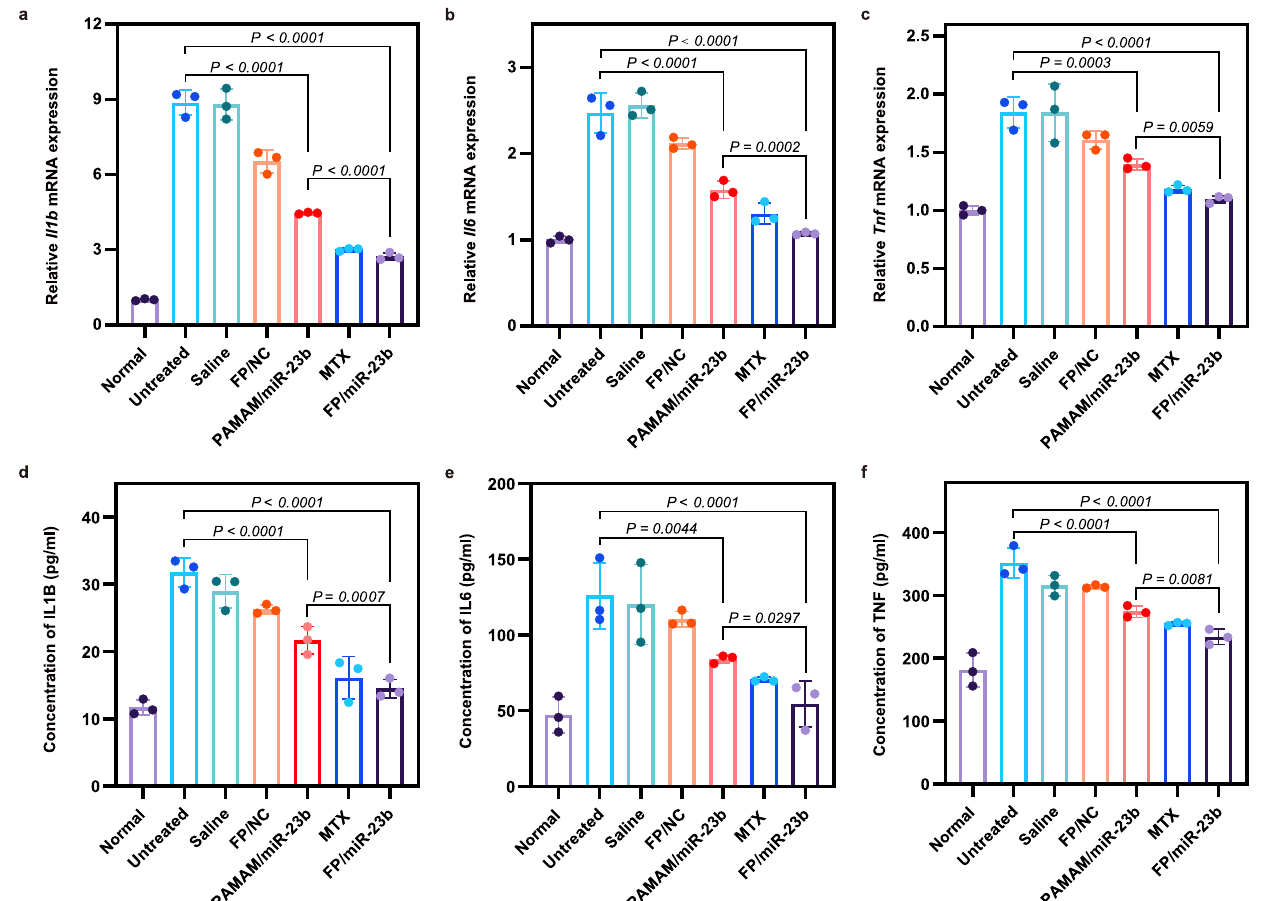
Fig. 8 | Levels of pro-in fl ammatory cytokines in AIA rats. a – c Relative mRNA expressionof l1b ( a ), Il6 ( b ),and Tnf ( c )inthein fl amedsynovialtissuesmeasuredby qPCR at day 23 post-adjuvant induction. The expression levels were calculated as the ratio of related cytokines to Actb . d – f Concentrations of pro-in fl ammatory